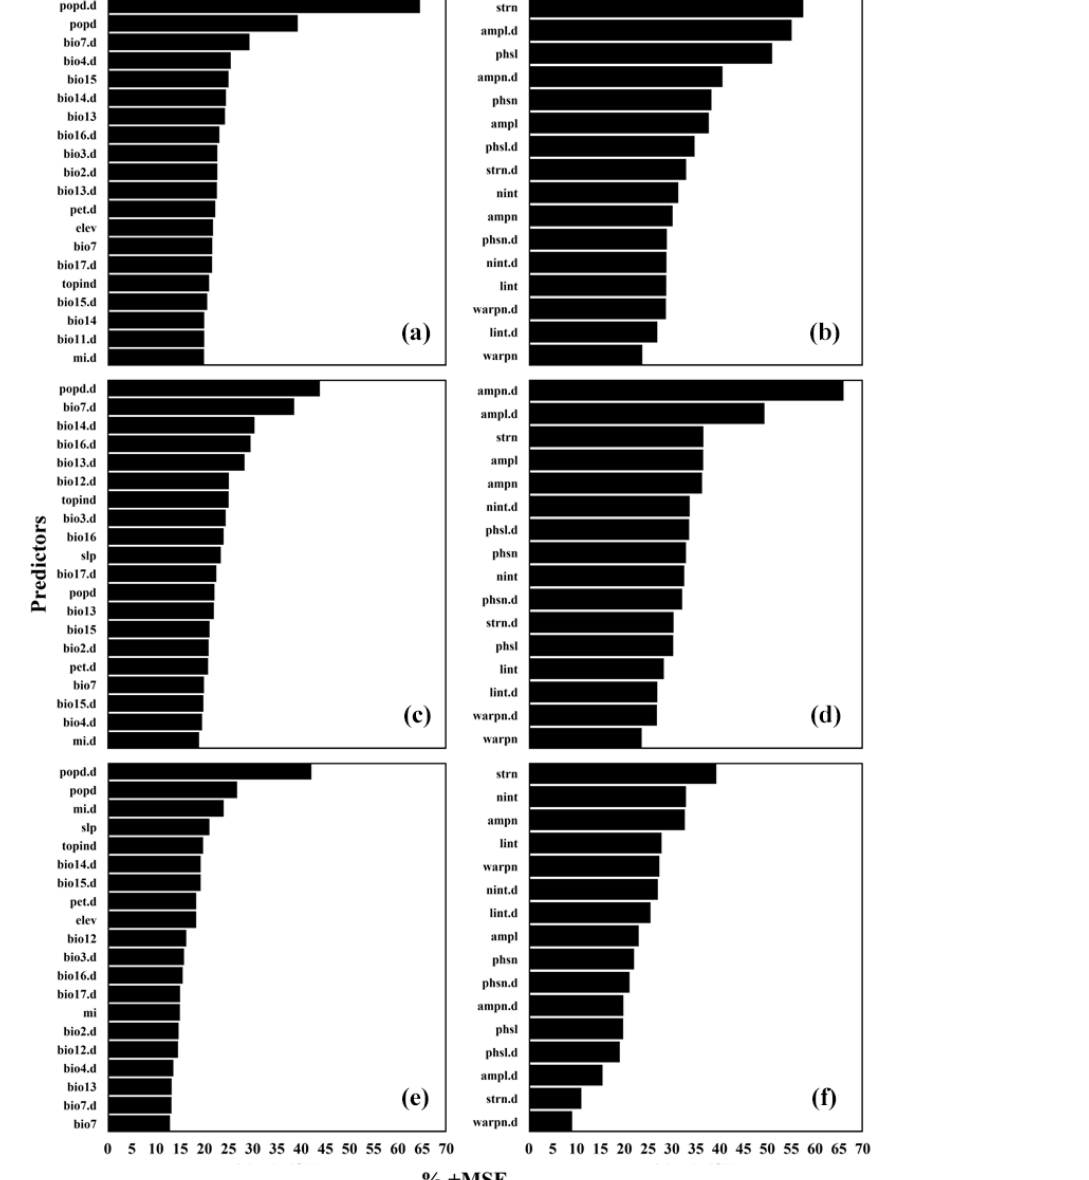
Figure 5. Percent mean squared error (MSE) increase after each of the top 20 non-remote-sensing (a, c, e) and 16 remote sensing (b, d, f) pre- dictors were omitted from the random forest ensemble model predicting the proportion of crops, savanna, and forest in the calibration sample frames, respectively. The models explained 63, 46, 62, 44, 62, and 46% of the proportion